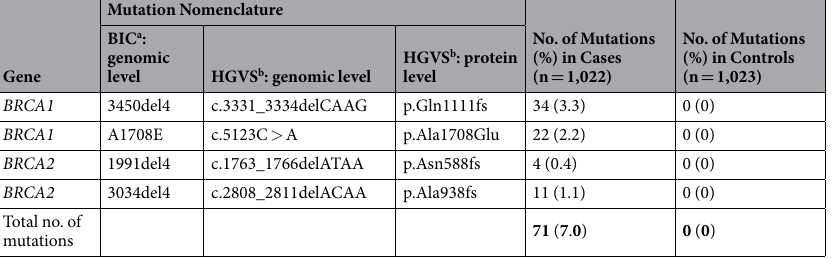
Table 4. Frequencies of the four small-range BRCA1/2 founder mutations in unselected breast cancer patients and controls from Col-BCCC. a BIC, Breast Cancer Information Core database as of October 2016 (https://